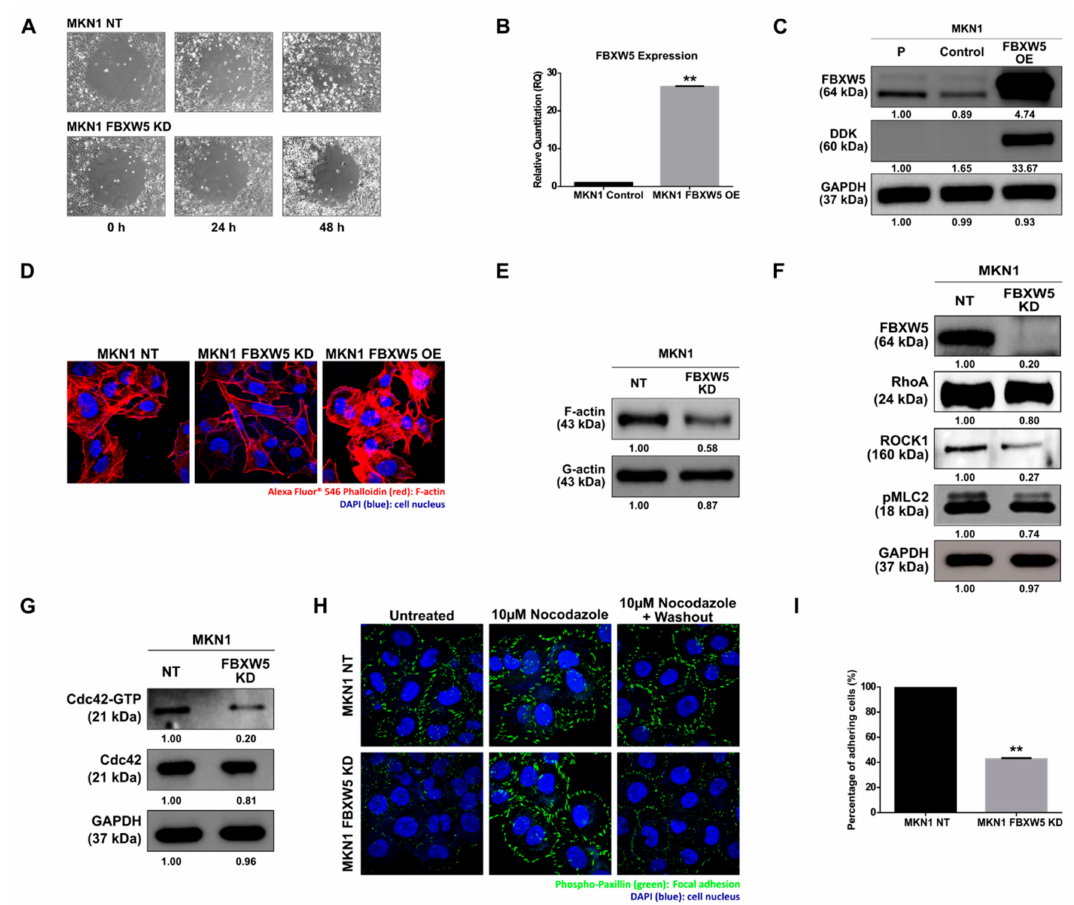
Figure 2. ( A ) Phase-contrast microscopic images (10 × ) of MKN1 NT and MKN1 FBXW5 KD cells, captured across three time points post removal of Radius Gel in the center of the well. At least two independent experiments were performed. ( B ) Quantitative real-time PCR analysis of FBXW5 mRNA expression in MKN1 control and MKN1 FBXW5 OE (overexpression) cells (** p -value = 0.009). Values represent the average of three independent experiments and error bars denote standard deviations. At least three independent experiments were performed. ( C ) Western blot analyses of FBXW5 and DDK protein expression in MKN1 cells (P: Parental; FBXW5 OE: FBXW5 overexpression variant of MKN1). GAPDH served as the loading control. At least three independent experiments were performed. ( D ) Immunofluorescent detection of F-actin (60 × , oil immersion) in MKN1 NT, MKN1 FBXW5 KD, and MKN1 FBXW5 OE cells. Red: Phalloidin 546 labelled F-actin; blue: DAPI stained cell nucleus. At least two independent experiments were performed. ( E ) Western blot analyses of F-actin and G-actin protein expressions in MKN1 NT and MKN1 FBXW5 KD cells. At least two independent experiments were performed. ( F ) Western blot analyses of FBXW5, RhoA, ROCK1, and pMLC2 protein expressions in MKN1 NT and MKN1 FBXW5 KD cells. GAPDH served as the loading control. At least two independent experiments were performed. ( G ) Western blot analyses of Cdc42–GTP and Cdc42 protein expressions in MKN1 NT and MKN1 FBXW5 KD cells. GAPDH served as the loading control. At least two independent experiments were performed. ( H ) Immunofluorescent detection of focal adhesions (60 × , oil immersion) in MKN1 NT and MKN1 FBXW5 KD cells, under three di ff erent conditions. Green: Alexa Fluor 488 labelled phospho-paxillin; blue: DAPI stained cell nucleus. At least two independent experiments were performed. ( I ) Percentage of adherent MKN1 NT and MKN1 FBXW5 KD cells quantified by microscopic examination (** p -value = 0.006). A total of four di ff erent fields were counted, and the average cell number was determined. Values represent the average of two independent experiments and error bars denote standard